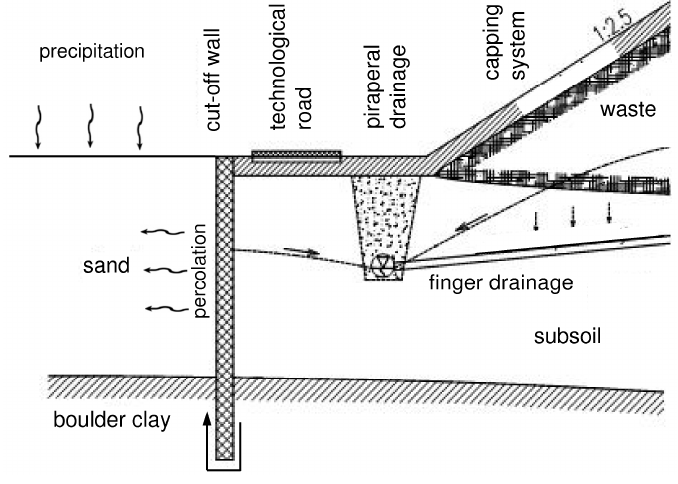
Figure 2. Scheme of the groundwater protection system against leachates from the MSW Łubna landfill [14].